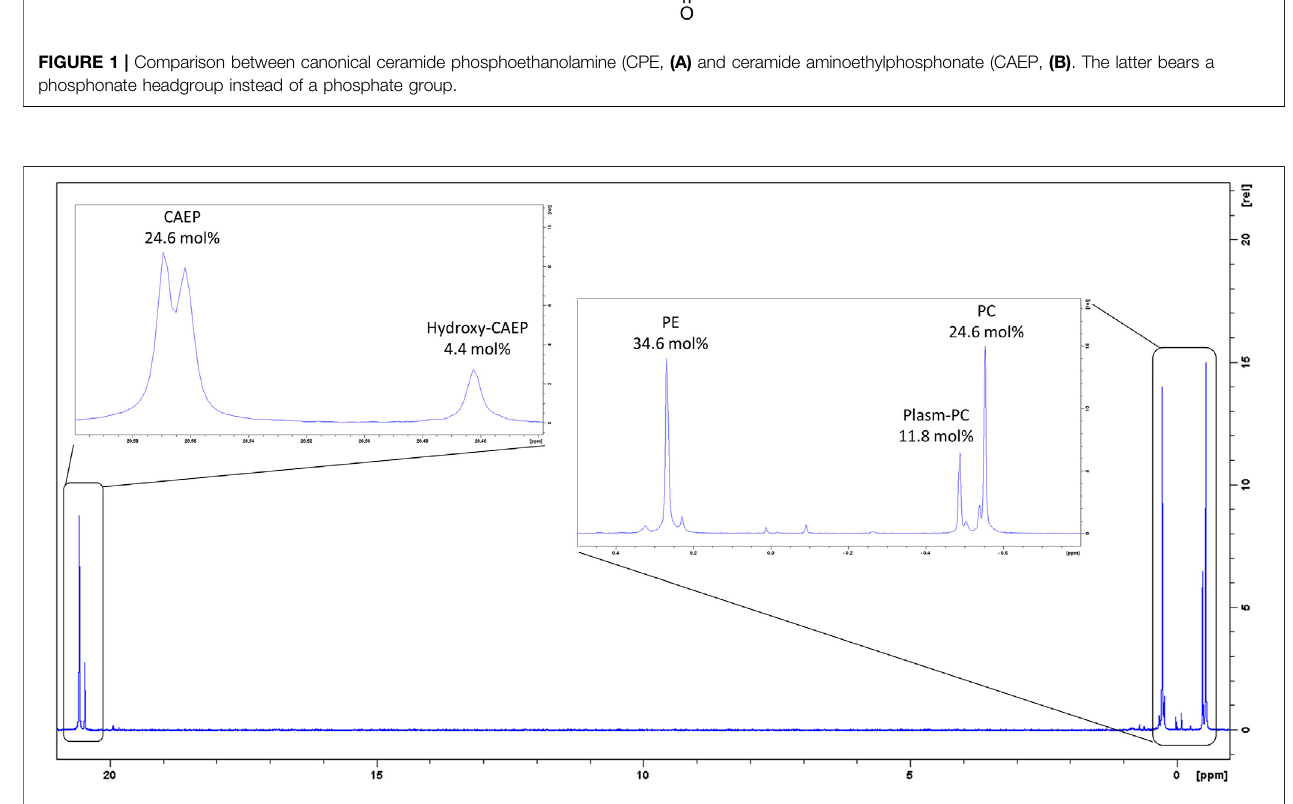
FIGURE 2 | 31 P-NMR spectrum of M. galloprovincialis hemocytes raw extract.